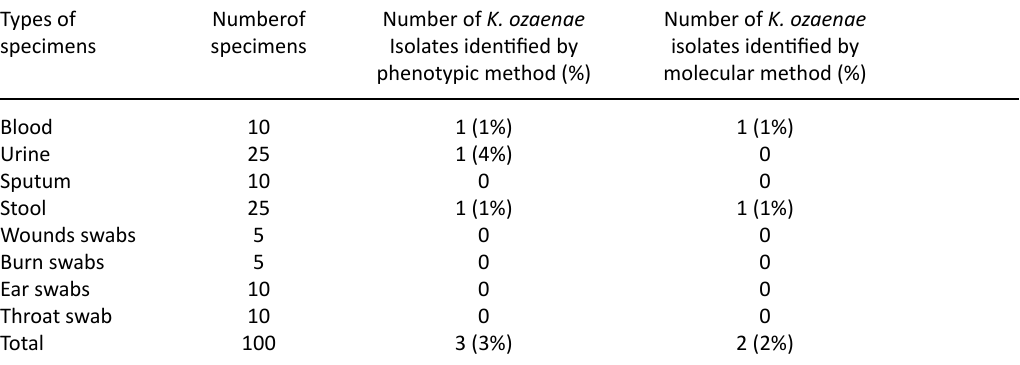
Table 1. Specimens profile and isolation percentage of K. ozaenae identified by phenotypic and molecular methods Types of